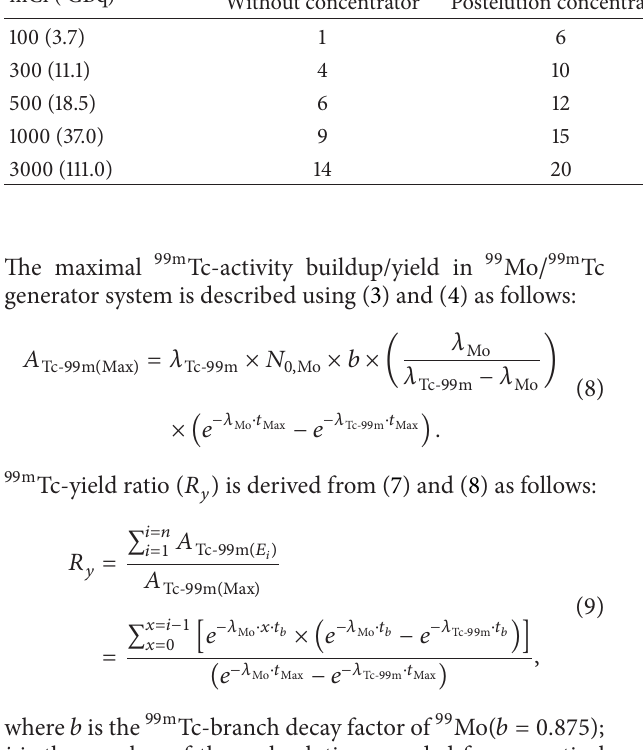
Table 2: Performance of 99m Tc radioisotope concentrator device ULTRALUTE (effect of concentrator on generator useful life) [41, 61]. Generator